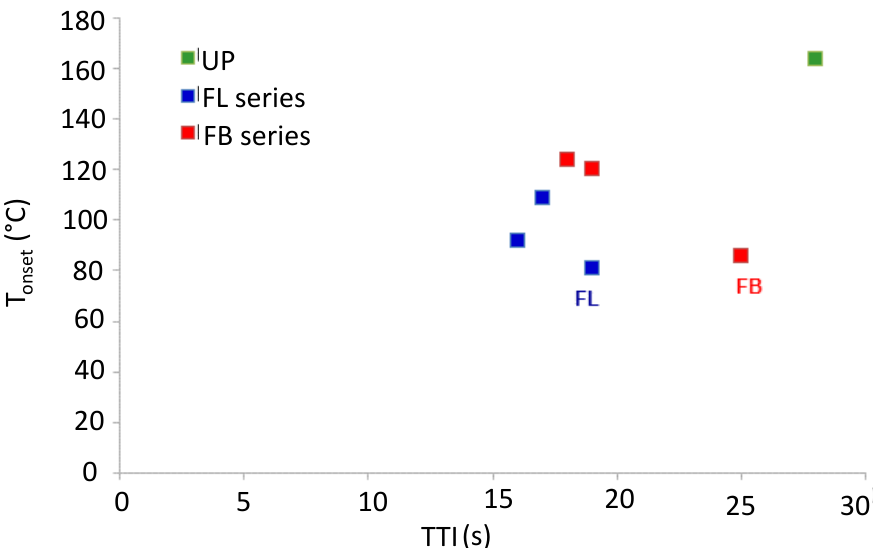
Figure 6. Plot of T onset from TGA data vs. TTI from cone calorimetric data for cured resins and resin blends.